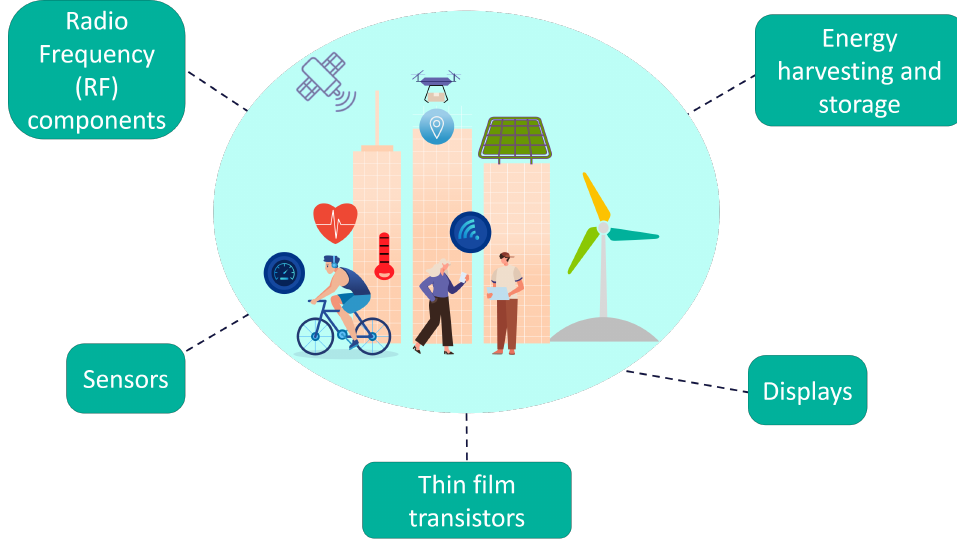
Figure 2. Printed electronic component classes reported in the present